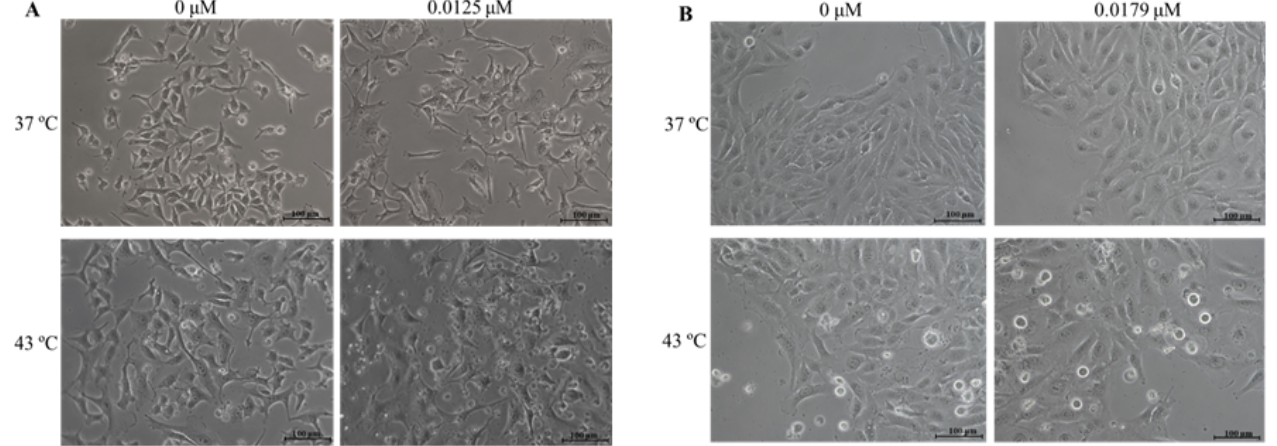
Figure 3. Effect of hyperthermia plus DOX on morphology of A375 and MNT-1 cells. Cells were exposed to 43 °C for 30 min and 0.0125 μ M or 0.0179 μ M of DOX, in case of A375 or MNT-1 cells, exposed to 43 ◦ C for 30 min and 0.0125 µ M or 0.0179 µ M of DOX, in case of A375 or MNT-1 cells, respectively. ( A )—A375 cells; ( B )—MNT-1 cells. respectively. ( A )—A375 cells; ( B )—MNT-1